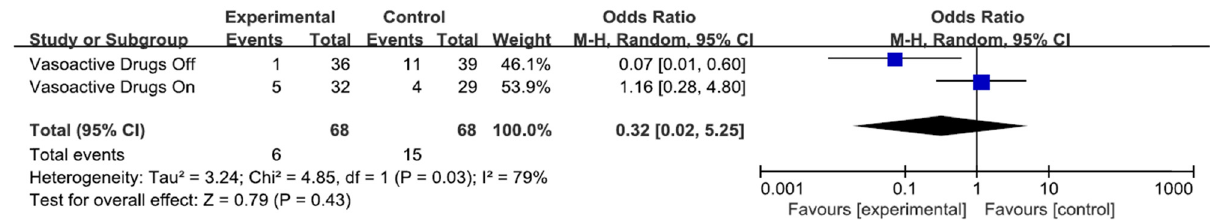
Figure 4: Subgroup analysis of patients who received vasoactive drugs versus those who did